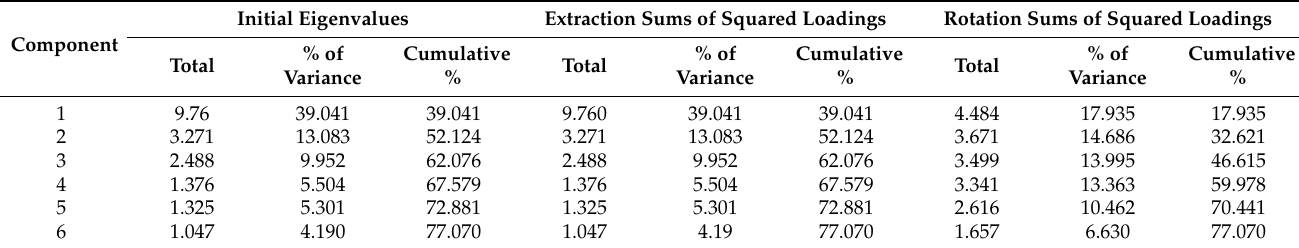
Table 4. Total Variance Explained by